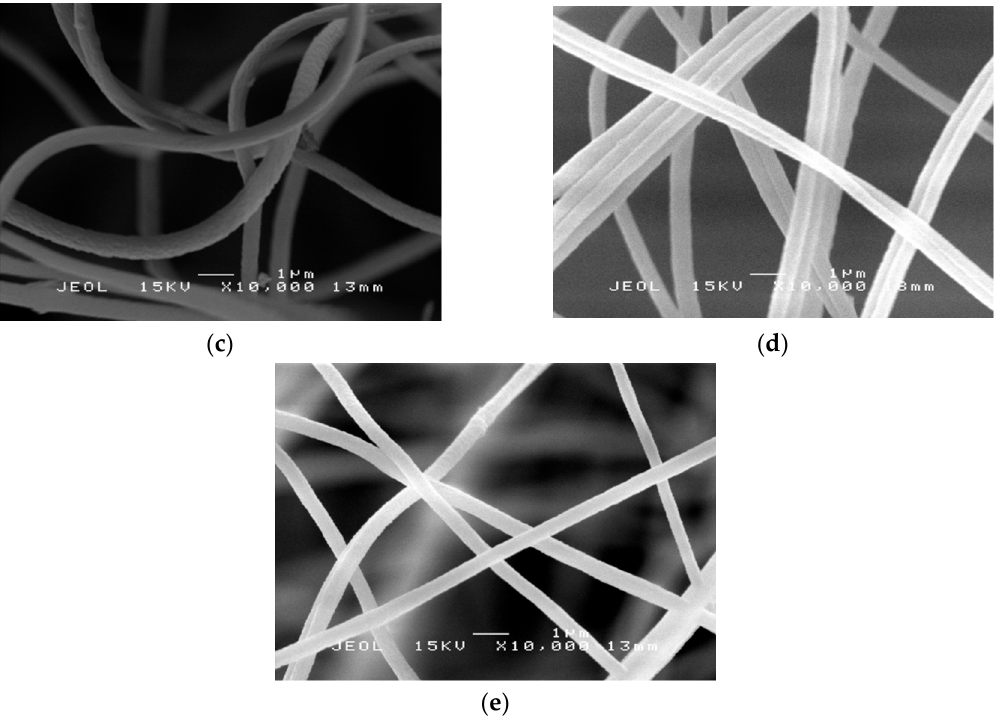
Figure 3. SEM micrographs of PAN/SL nanofibers: ( a ) 50:50, ( b ) 60:40 ( c ) 70:30 ( d ) 80:20 and ( e ) 90:10.